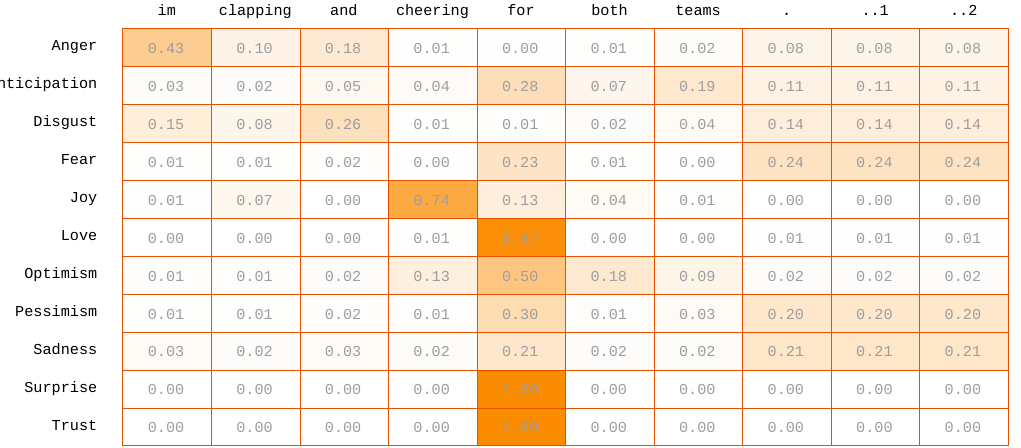
Figure 5. Attention visualization example. Golden labels are { joy , optimism } and predicted labels are { joy (0.91) , optimism (0.51) }. 2/14/2019